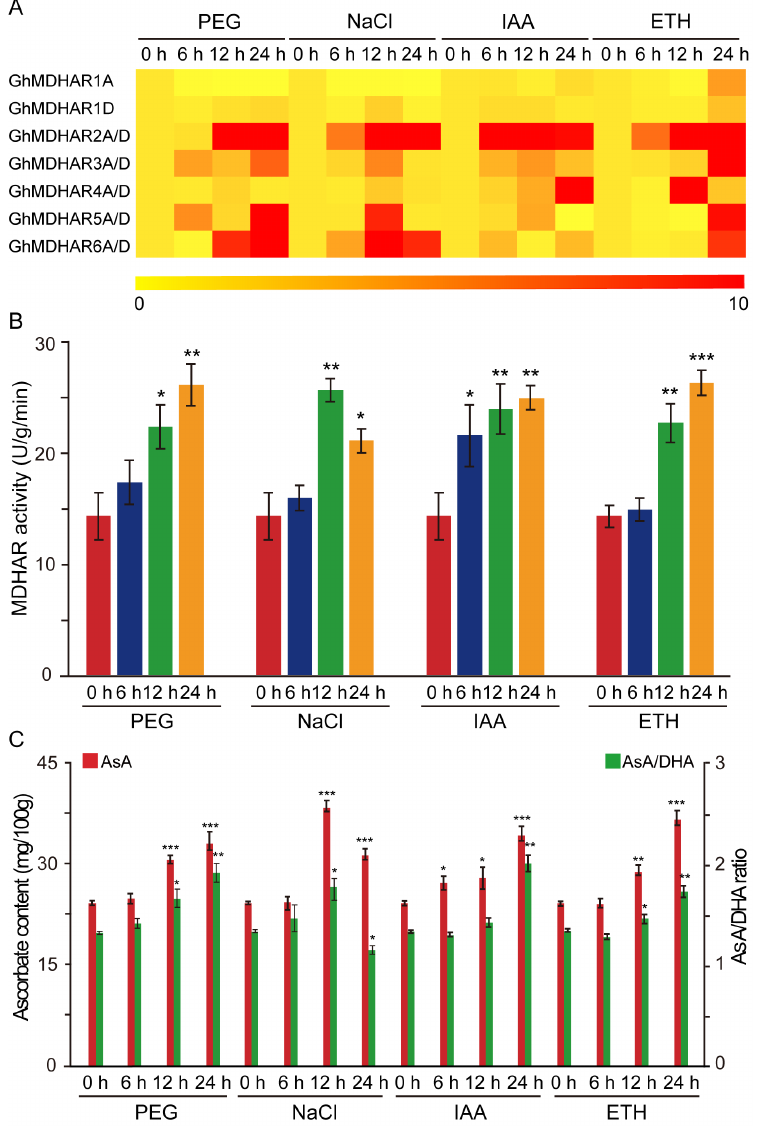
Figure 5. Expression analysis of GhMDHARs under abiotic stress and hormone treatment. The cotton leaf materials under the stresses of polyethylene glycol (PEG) and NaCl and the hormone treatments of indole-3-acetic acid (IAA) and ethylene (ETH) were collected and used for analyses of qRT-PCR, enzyme activity and AsA content, and AsA/ratio. ( A ) qRT-PCR-based heatmap of expression levels of GhMDHARs . The presented cotton leaf materials, with or without the treatments, were collected and extracted for RNA samples that were then used for qRT-PCR assay. The results were normalized using GhUBQ7 gene as internal control. The expression levels of untreated 0-h materials were artificially set to 1. The different color scale represents the distinct expression abundances with the colors of yellow, orange, and red to indicate regular, moderate, and high expression respectively. The heatmap was generated by R package. ( B ) Enzyme activity determination of MDHAR. The leaves treated by the stress and hormone treatments were utilized for enzyme solution extract and then for activity measurement. ( C ) Analysis of AsA content and AsA/DHA ratio under the stress and hormone treatments. Significant difference test was performed by one-way ANOVA using the value of untreated materials (0 h) as reference, with *, **, and *** to represent the differences at 0.05, 0.01 and 0.001 levels,